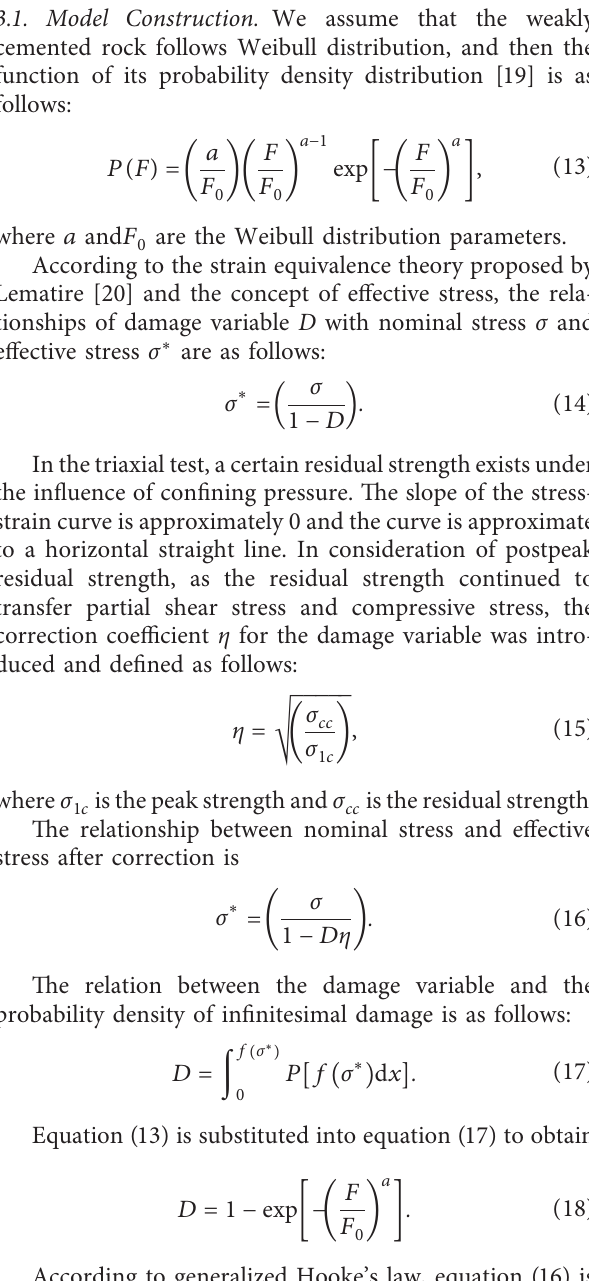
Figure 6: The relation curve of primary